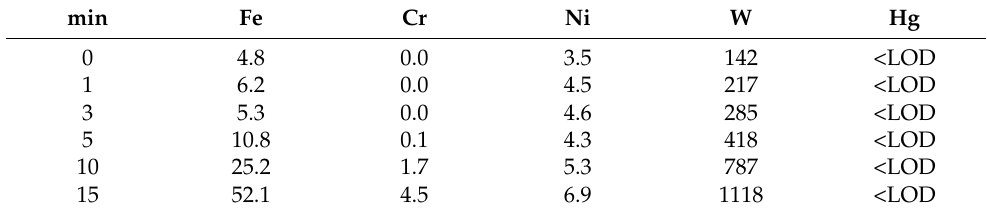
Table 1. Concentration in µ g/L of Fe, Cr, Ni, W and Hg measured in a sample of ultrapure water treated with surface plasma discharge for 15 min. LOD = Limit of